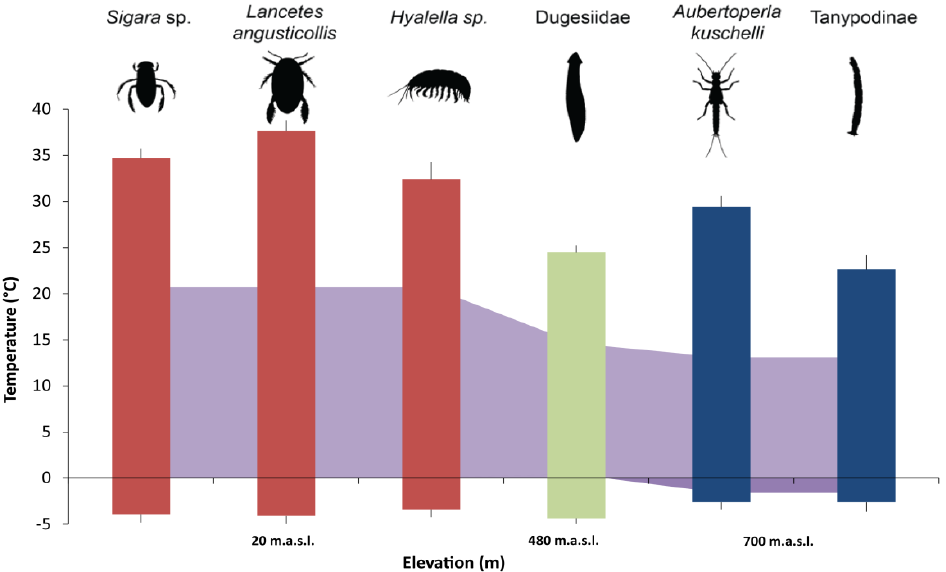
Figure 6. Thermal ranges of the studied taxa (±SD) compared with those of the different Róbalo watershed lagoons temperature range (purple shading in the background). Taxa restricted to a particular